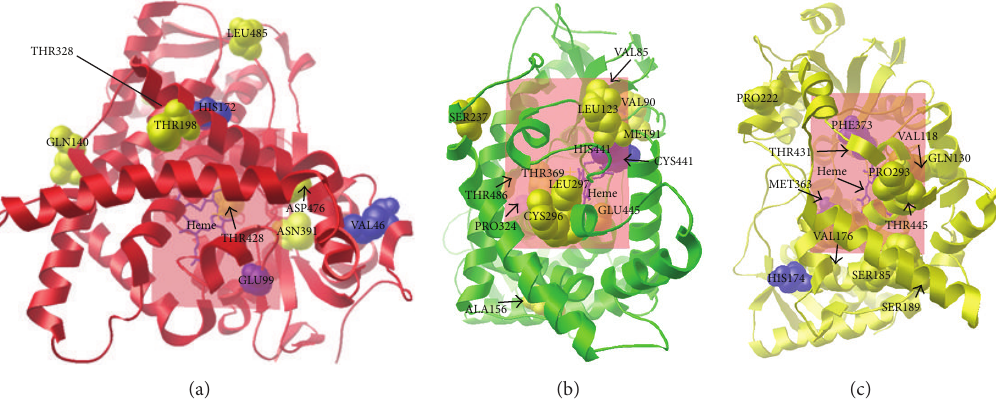
Figure 2: Grid box and flexible residues of (a) CYP2B6, (b) CYP2D6, and (c) CYP3A4, in ribbon representation. CPK represents SNP; blue CPKs represent mutation that lead to the lowest/highest binding affinity for R -/ S -methadone in CYP. Heme is in stick presentation. Red square resembles the grid box. Figure was generated using ADT4.0 [10,